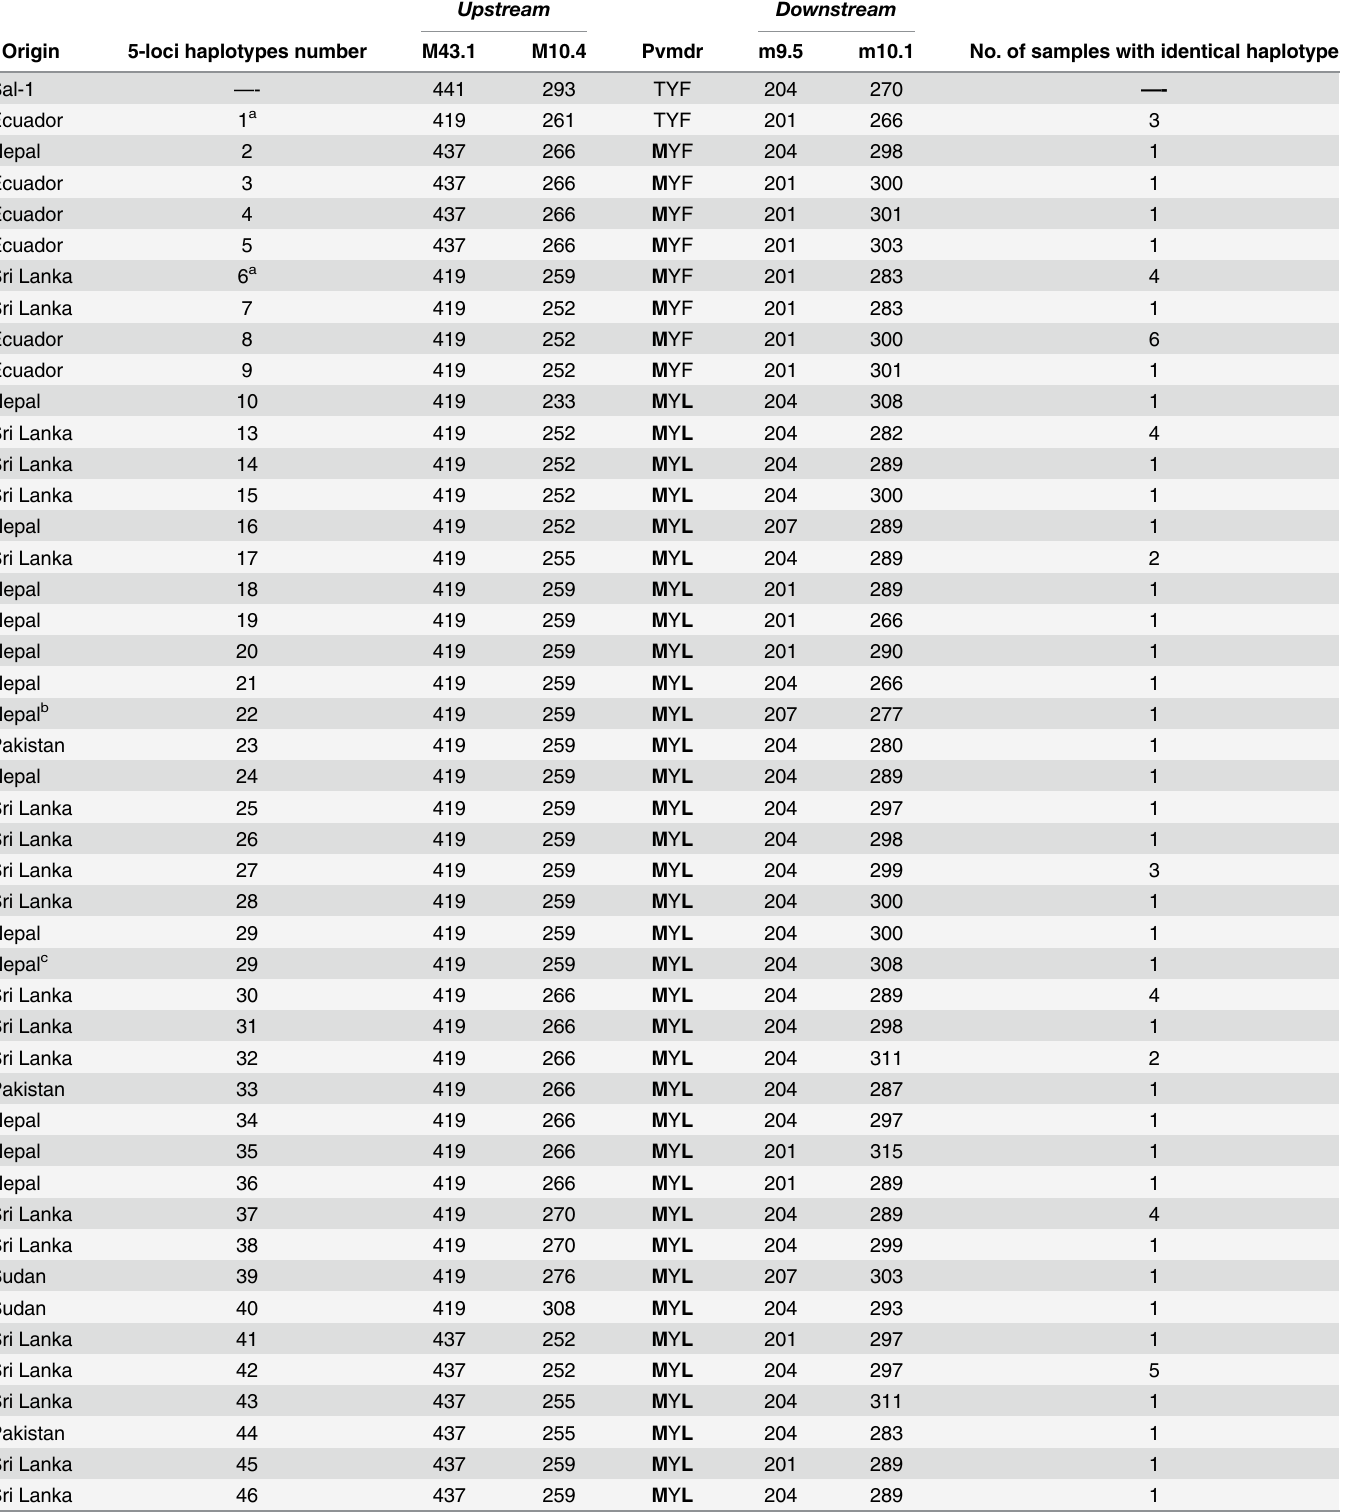
Table 3. Plasmodium vivax mdr1 alleles TYF, MYF and MYL and flanking microsatellite alleles.